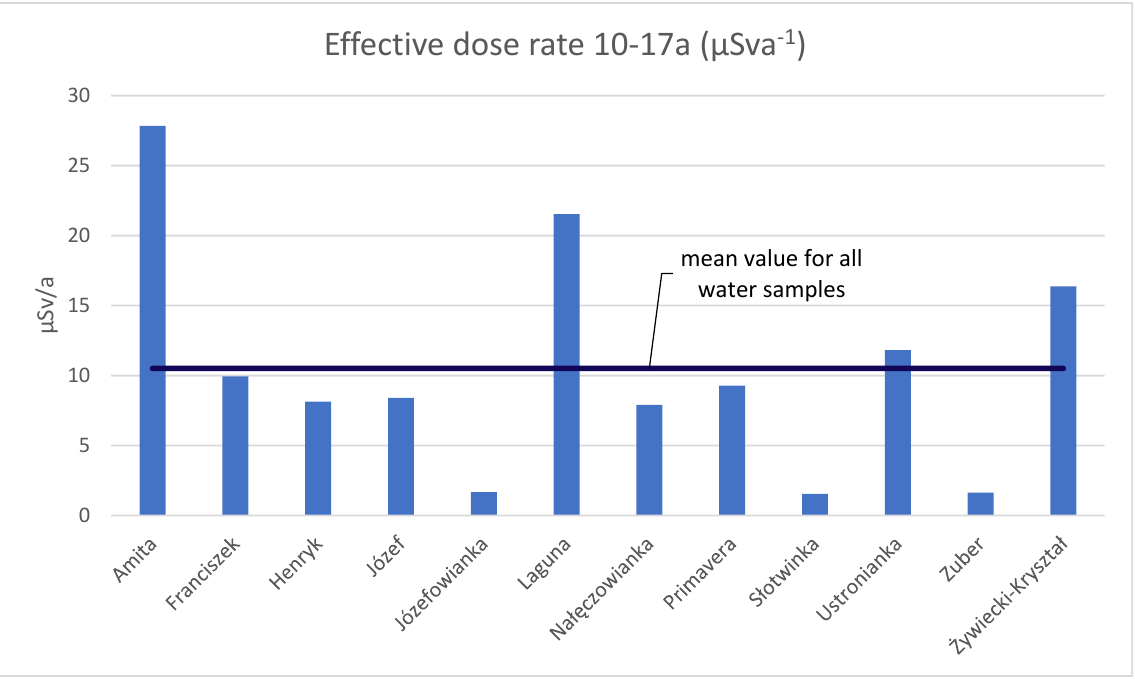
Figure 5. Annual effective dose for adolescents from 10 to 17 years of age from the consumption of individual mineral waters.